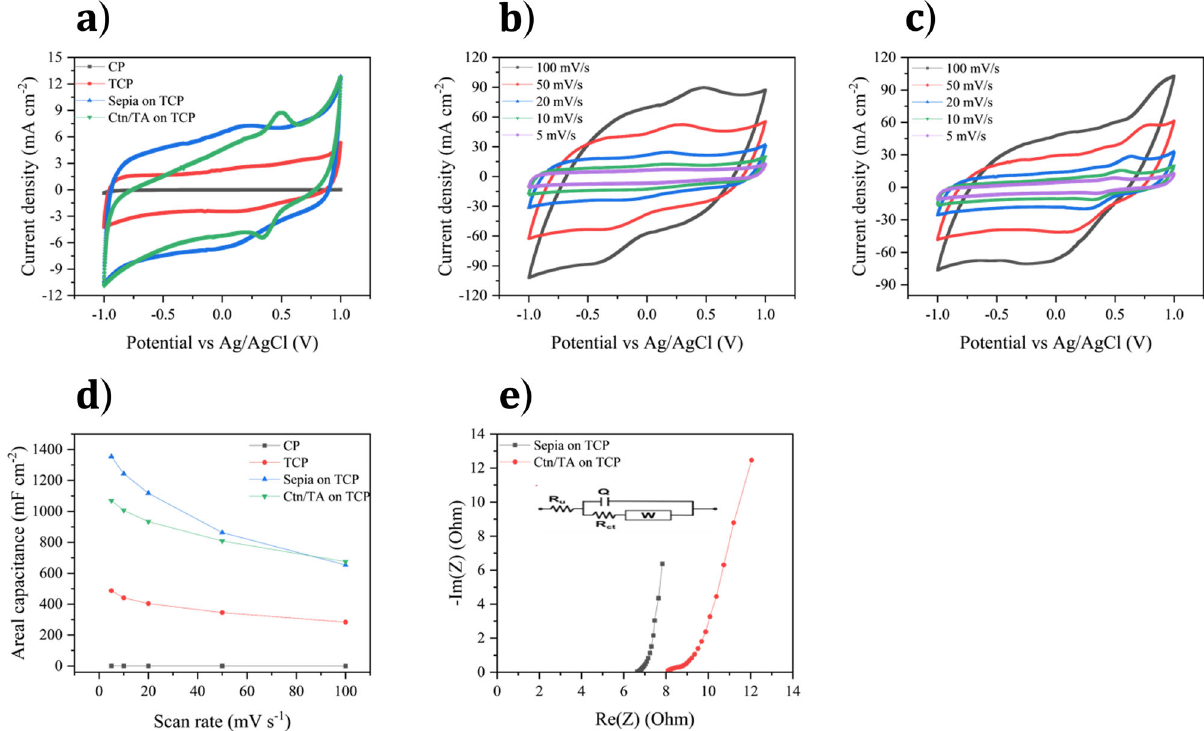
Fig. 4 Electrochemical characterization of bare CP, bare TCP, and sepia on TCP and Ctn/TA on TCP. ( a ) Cyclic voltammetry at 5 mV s − 1 . Cyclic voltammetry at different scan rates of ( b ) sepia on TCP, ( c ) Ctn/TA on TCP. ( d ) Capacitance vs scan rate for the aforementioned samples, obtained from cyclic voltammetry. ( e ) Nyquist plot for sepia and Ctn/TA on TCP in the frequency range 4.25 × 10 3 − 10 − 1 Hz. Inset: corresponding simpli fi ed simulated circuit where R u is the uncompensated resistance, R ct is the charge-transfer resistance, Q is the constant phase element, and W is the Warburg